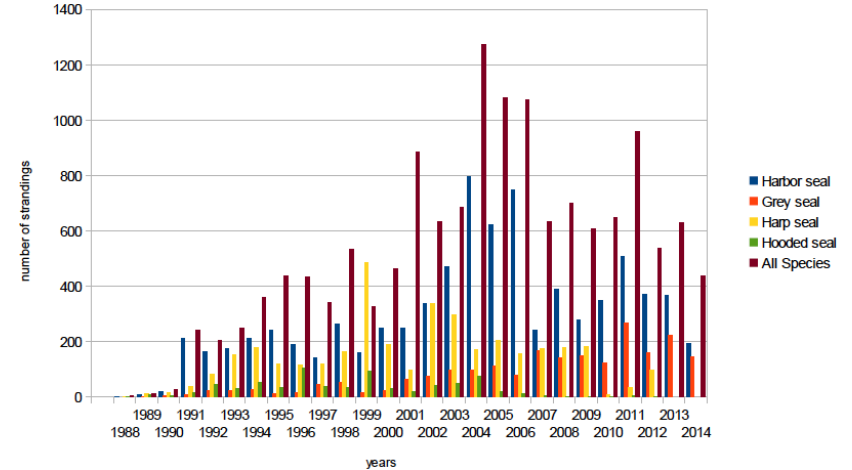
Figure 3. Pinniped strandings by species for the US Atlantic coast for the period 1988 to 2014. The peaks in strandings in 1991/1992; 1998/1999, and from 2004 to the end of 2007 were associated with confirmed PDV infection in harbor [54], harp and hooded seals [55], and grey seals